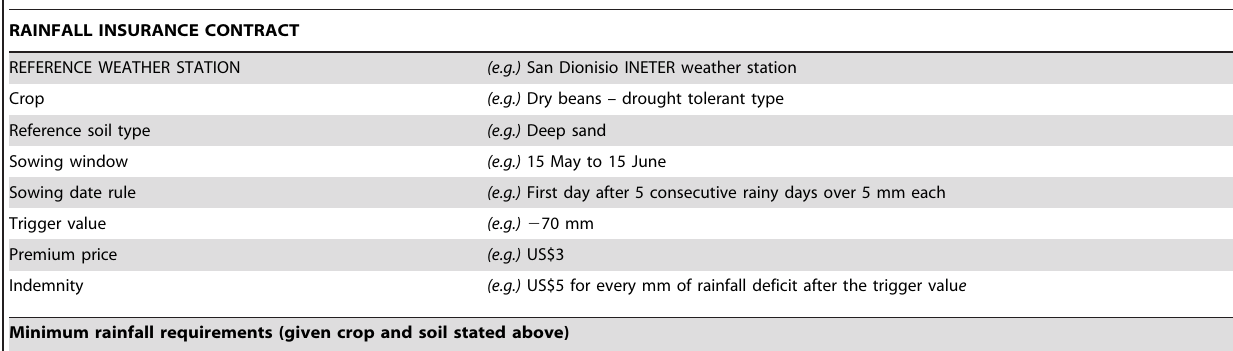
Basis risk Details